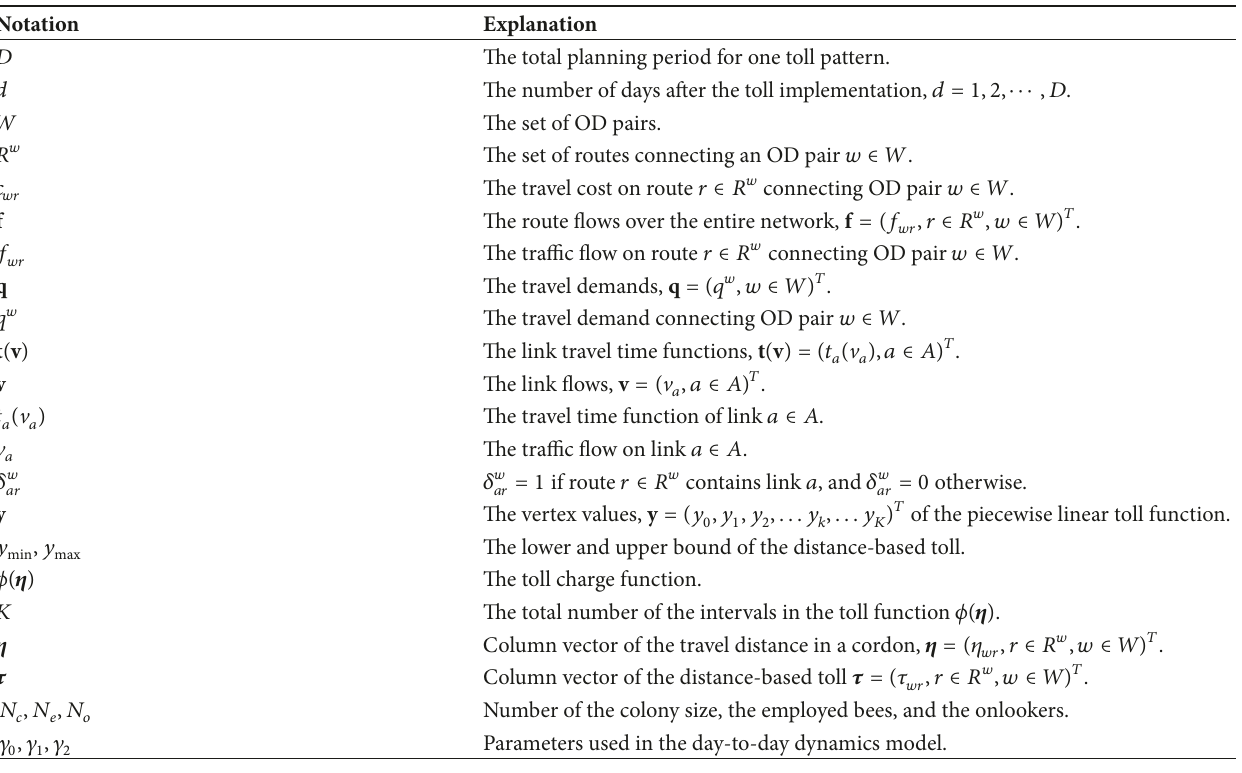
Table 1: List of notations.